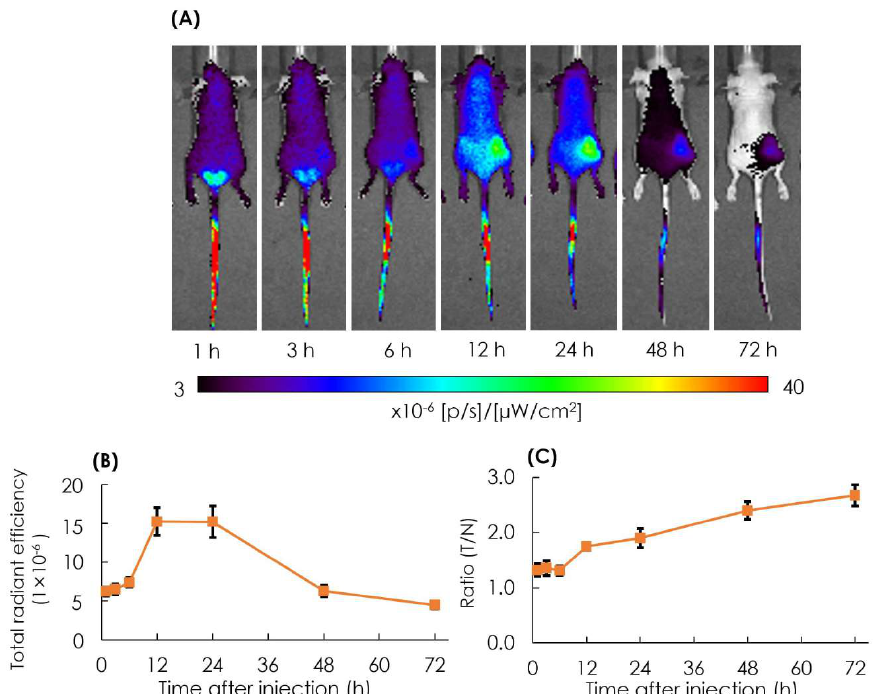
Figure 6. In vivo NIRF imaging of the 4T1 tumor-bearing mice after i.v. injection with ICG-labeled AB-Lac particles ( A ); the graph of fluorescence intensity in tumor lesions ( B ) and the ratio of tumor intensity in normal tissue injected with ICG-labeled AB-Lac particles ( C ). Data are expressed as mean ± S.E.M. ( n =